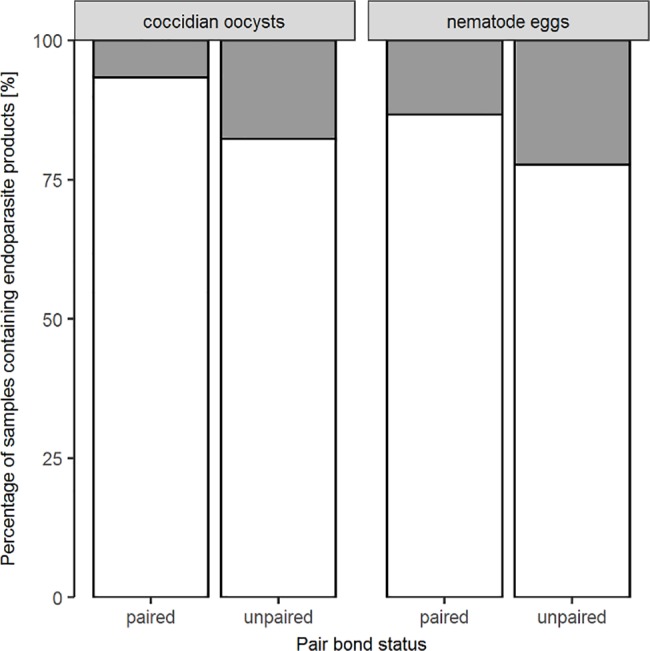
Differences in excretion patterns of endoparasite products depending on pair bond status.Percentage of samples containing (grey bars) as well as not containing (white bars) endoparasite products for paired and unpaired individuals. Npaired = 10, Nunpaired = 22, Nsamples = 130.